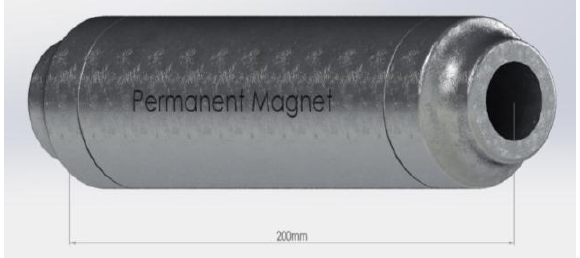
Figure 3. Permanent magnet used in this study.